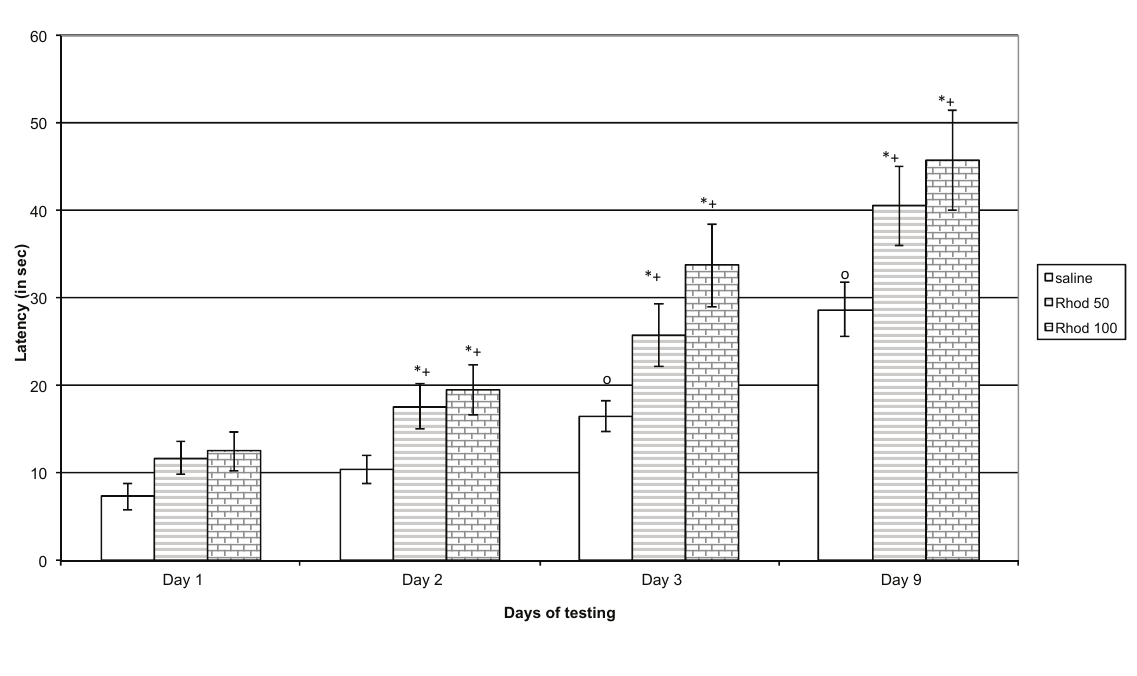
Figure 1. Effects of Rhodiola rosea extract on step-down test in naïve rats. Abscissa: 2-day learning session, short and long memory retrieval. Ordinate: the latency of reaction in seconds. o P<0.05 compared to the fi rst day control; * P<0.05 compared to the fi rst day of respective group; + P<0.05 compared to the same day control.